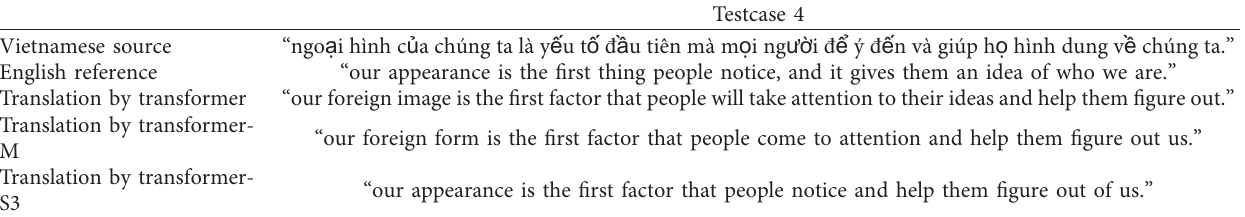
Table 10: Translations of a Vietnamese sentence comprising 25 tokens.